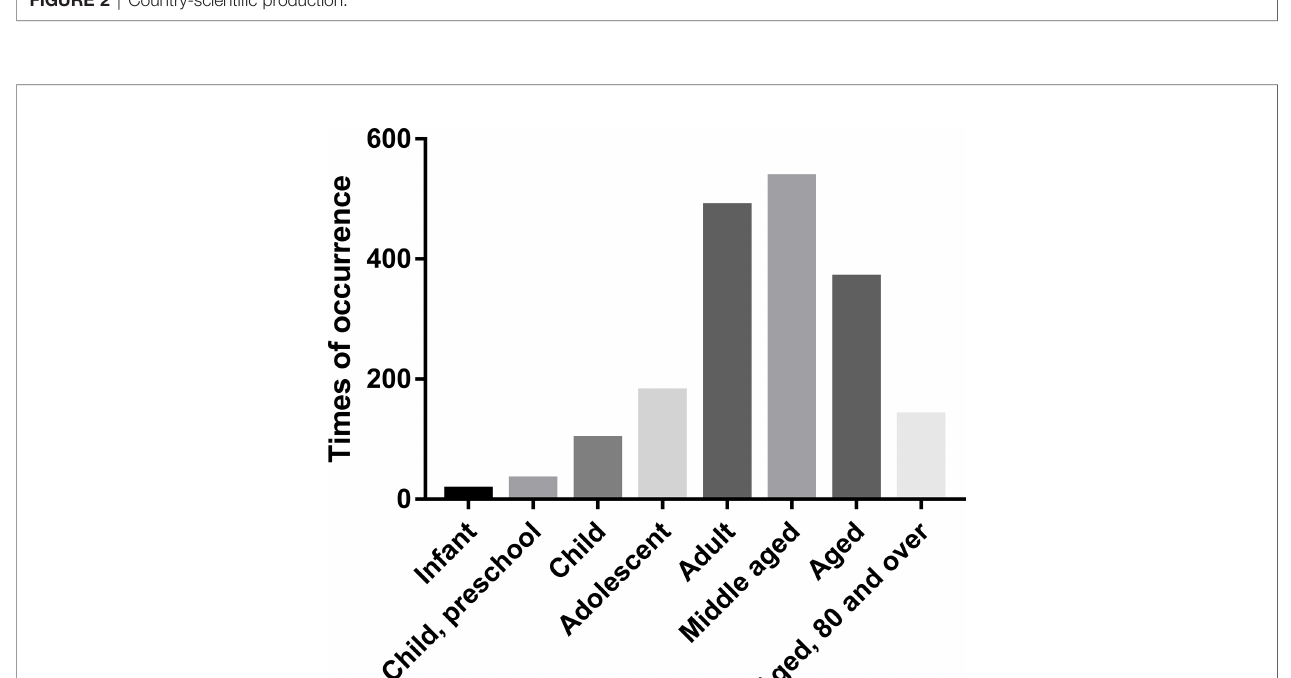
FIGURE 2 | Country-scienti fi c production.